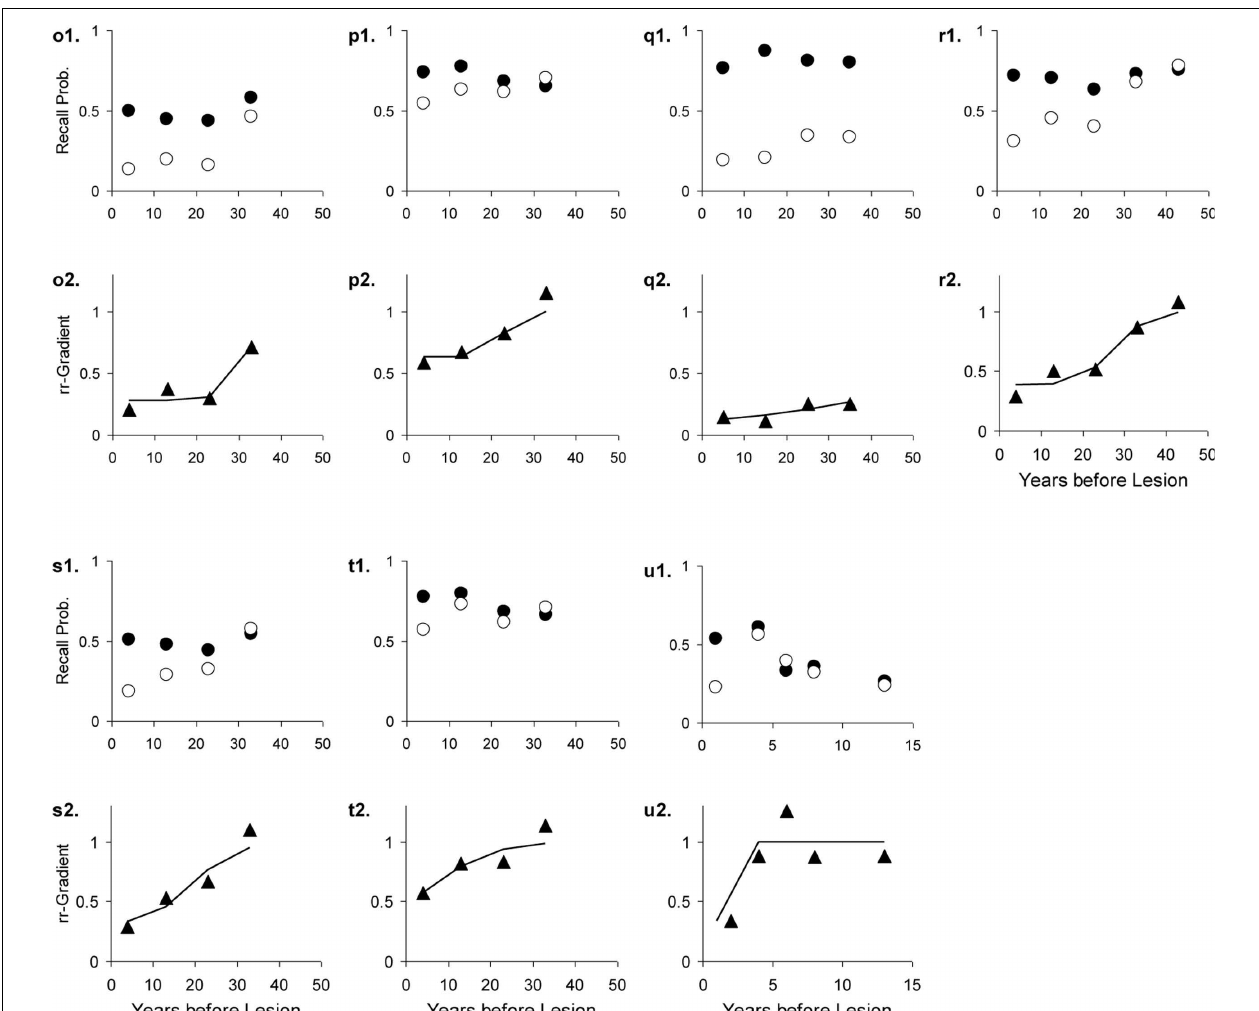
FIGURE 13 | Seven studies with various patient groups and matched controls. The letters with each panel correspond to those in Table 3 . See Figure 10 for further